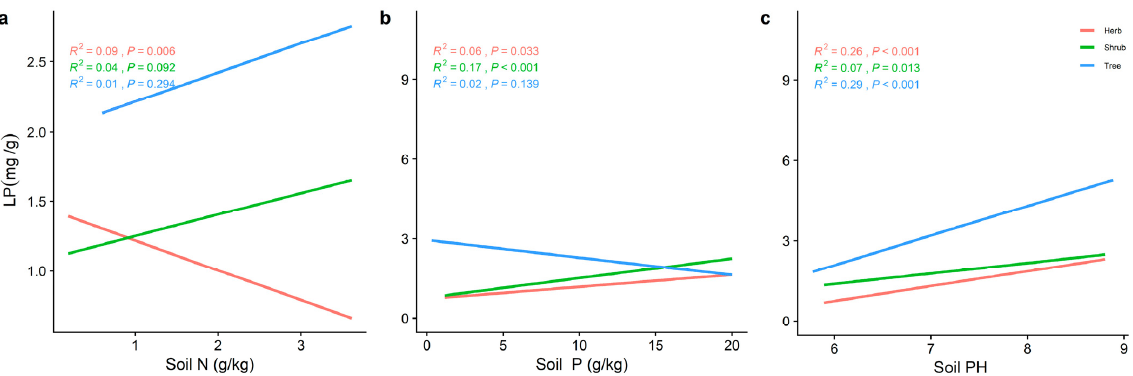
Figure 7. The general linear analysis of soil factors with different life forms of LP. ( a ) General linear relationship between the soil N and LP of plants in the trees, shrubs, and herbs ( b ) General linear relationship between the soil P and LP of plants in the trees, shrubs, and herbs. ( c ) General linear relationship between the soil pH and LP of plants in the trees, shrubs, and herbs. The red line represents the tree level, the green line is the shrub level, and the blue line is the herb level. R 2 represents how well the model fits the variables studied and the p -value represents the level of significance.